Question: Identify the chart type used in this figure.
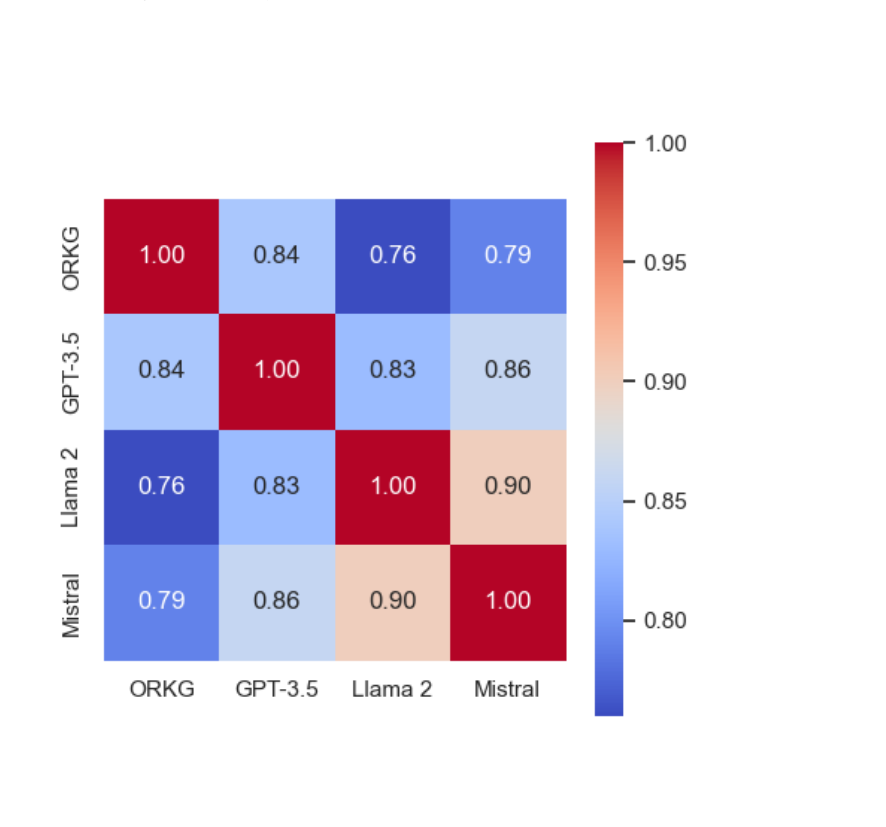
Answer: heatmap